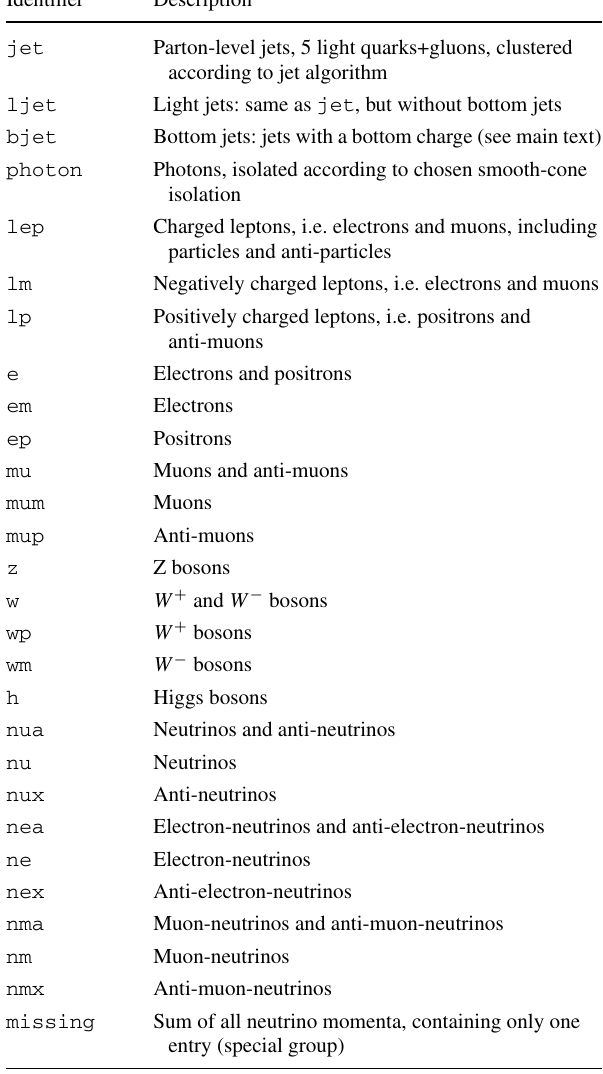
Table3 Allrelevantparticlegroupspredefinedin Matrix .Eachgroup isorderedbythetransversemomentaoftherespectiveparticles,starting with the hardest one. These groups are most important to recognize by the user in two situations: when using the predefined blocks for fidu- cial cuts and when defining distributions (see Sect. 5.1.3). Furthermore, they can be accessed directly in the C++ code which is essential to the advanced user when defining user-specified scales, cuts and